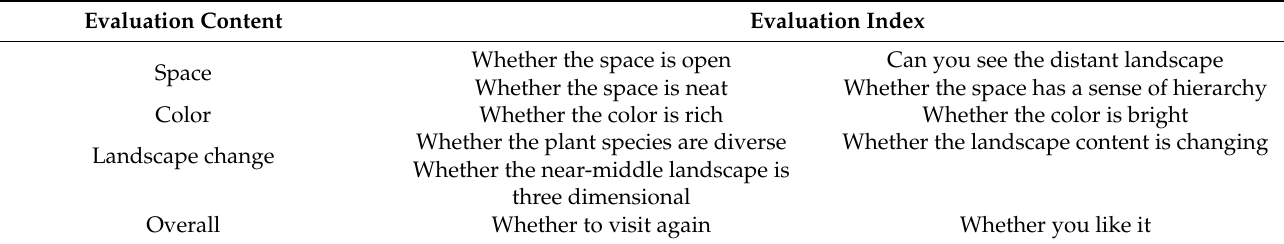
Table 2. Index selection of landscape cognitive